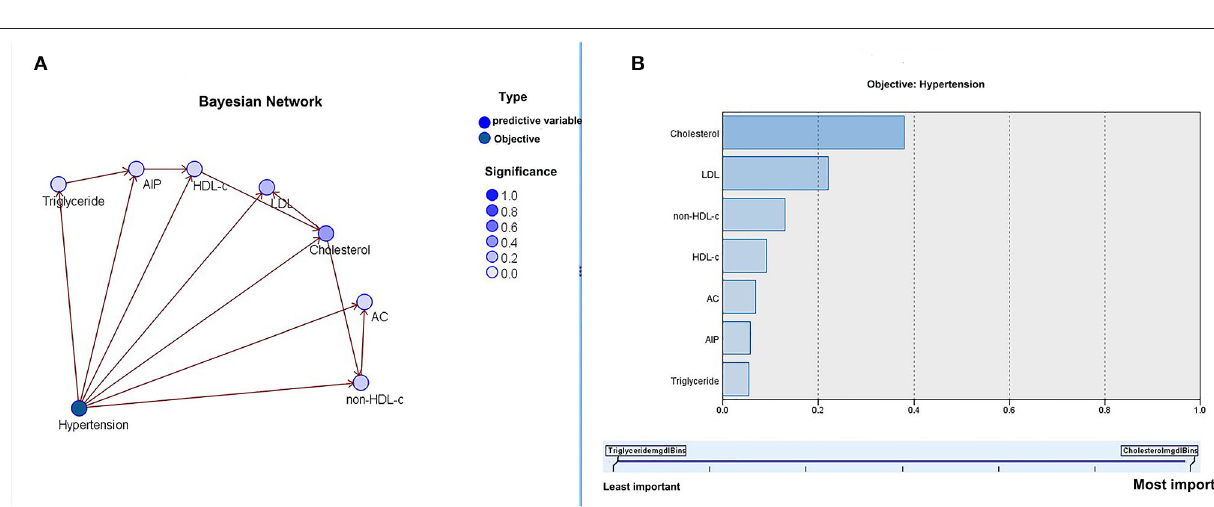
FIGURE 5 | The Bayesian model based on the tree augmented native (TAN) algorithm: the relationship between lipid profiles, atherosclerotic indices, and the incidence of hypertension (A) and importance of predictors (B)